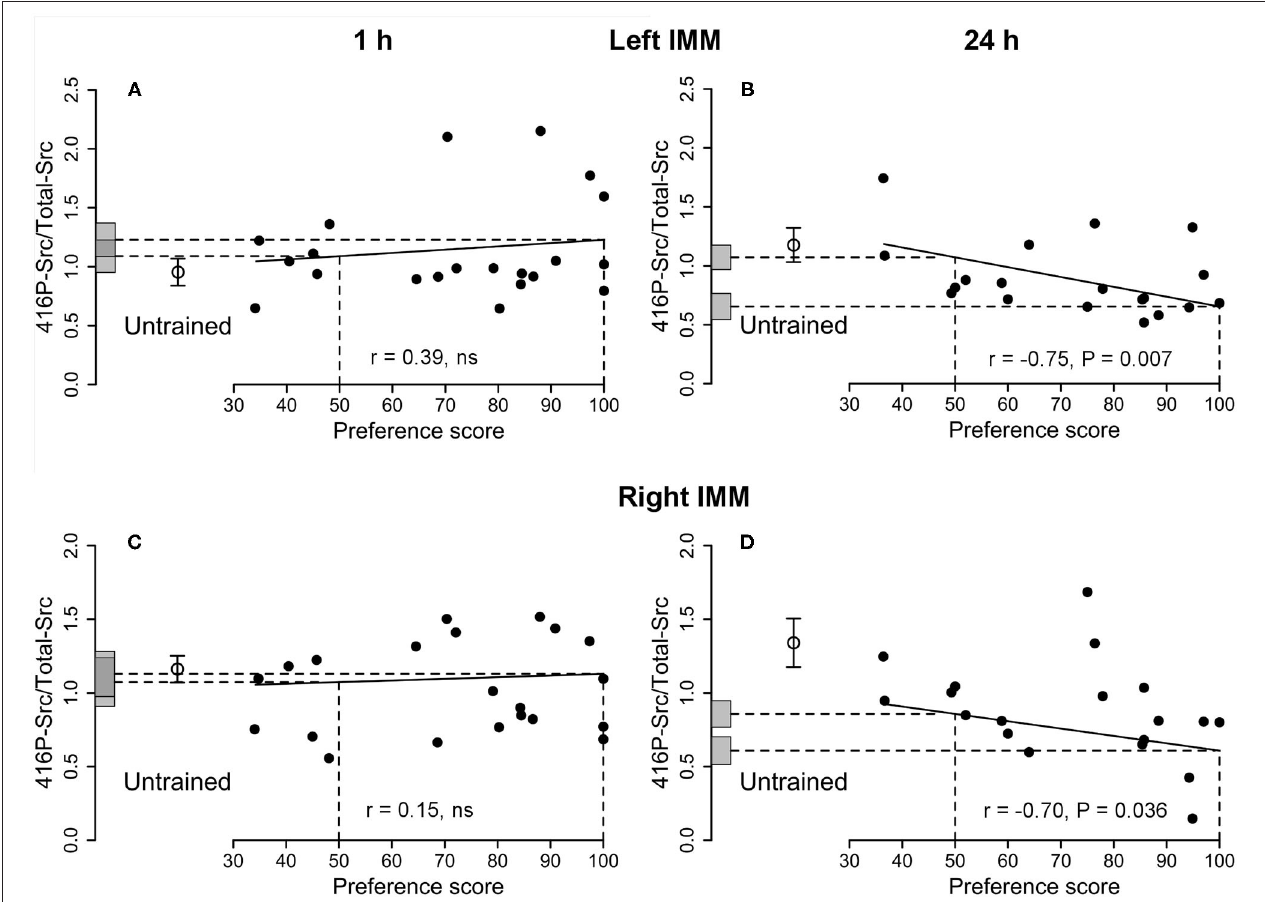
FIGURE 4 | Left and right IMM, 1 and 24h after the end of training. 416P-Src/Total-Src plotted against preference score. Conventions as for Figure 1 . (A,B) Left IMM; (C,D) right IMM; (A,C) 1h after the end of training, correlations not significant. (B,D) Twenty four hours after the end of training, both correlations significant. In both left and right IMM at 24h (B,D) , the intercept at preference score 100 is significantly different from the mean of untrained chicks. In the right IMM at 24h (D) , the intercept at preference score 50 is also significantly different from the mean of untrained chicks. Data in (D) are corrected for effects of approach during training and testing, which were statistically significant (cf. Supplementary Table S4